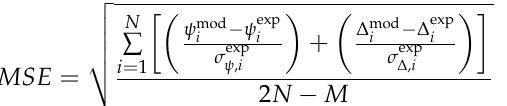
Table S1: Correlation factors between the free parameters of the fitting of the ellipsometry data for the different